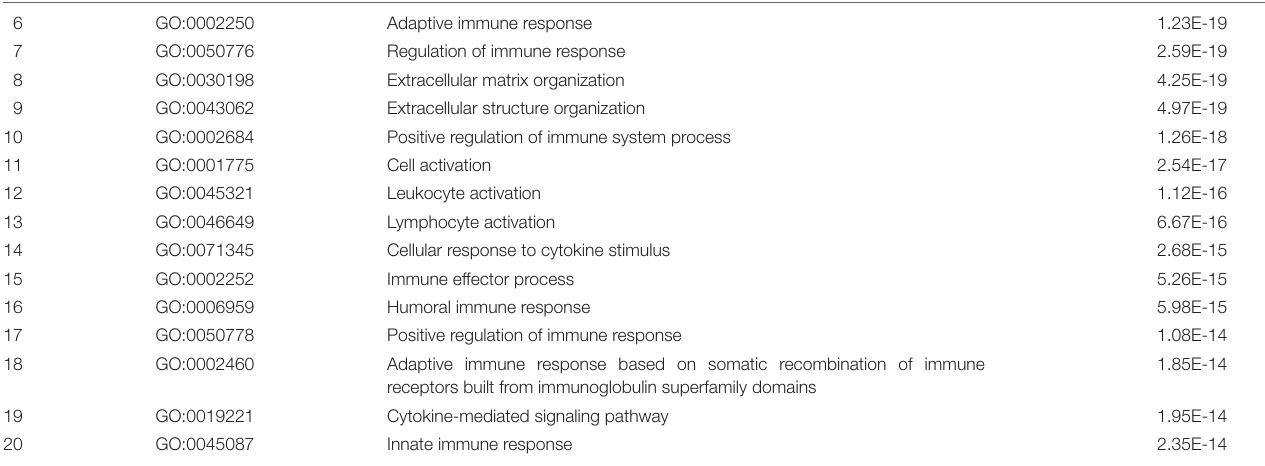
TABLE 3 | Results of functional enrichment analysis, performed by ‘ToppFun’ from the ‘ToppGene Suite’ Gene Ontology tool, of over- and under-expressed genes (with expression ratio ≥ 1.30 and ≤ 0.76, respectively) located on Hsa21 in the “Total transcriptome map”. Over-expressed genes